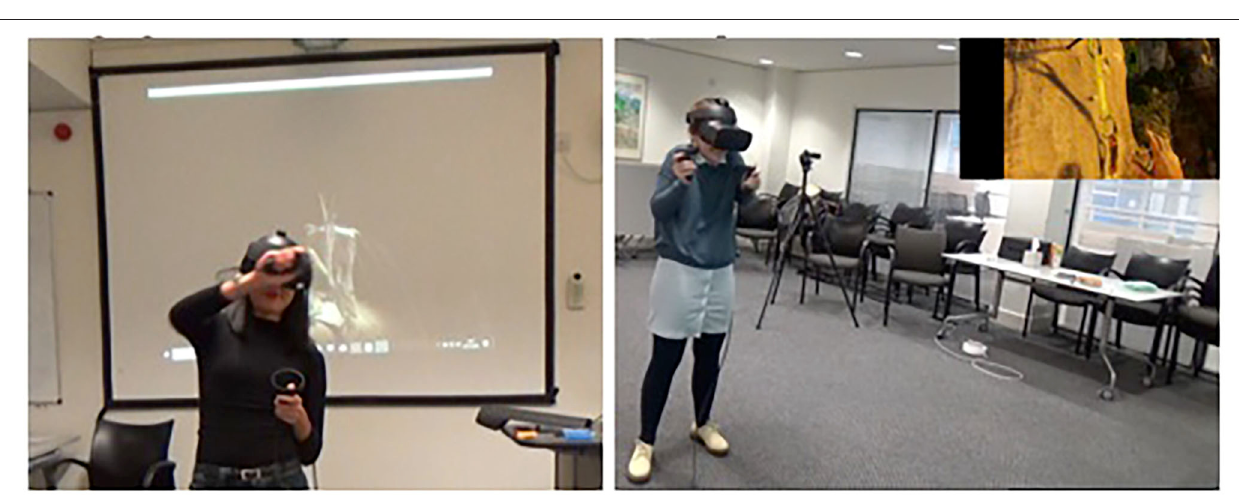
P5 moved her body slightly when the dinosaur became